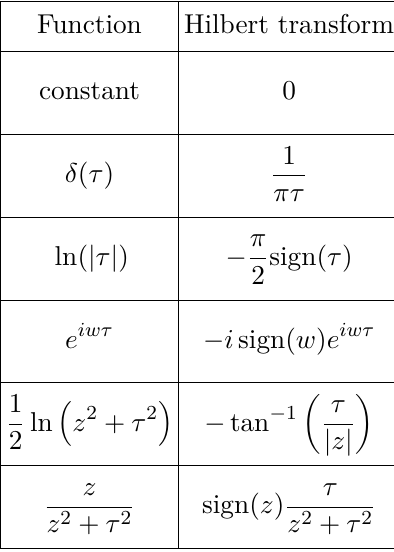
Table 1 . Examples of Hilbert transform pairs.